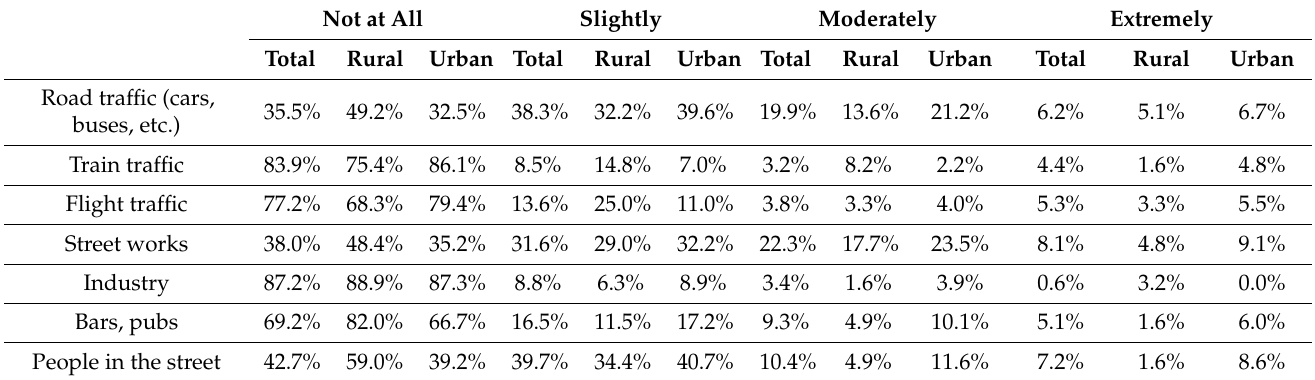
Table A2. Percentage of participants who reported disturbance from external sources of noise in rural and urban areas during the previous 3 months. Complementary data to Figure 1.